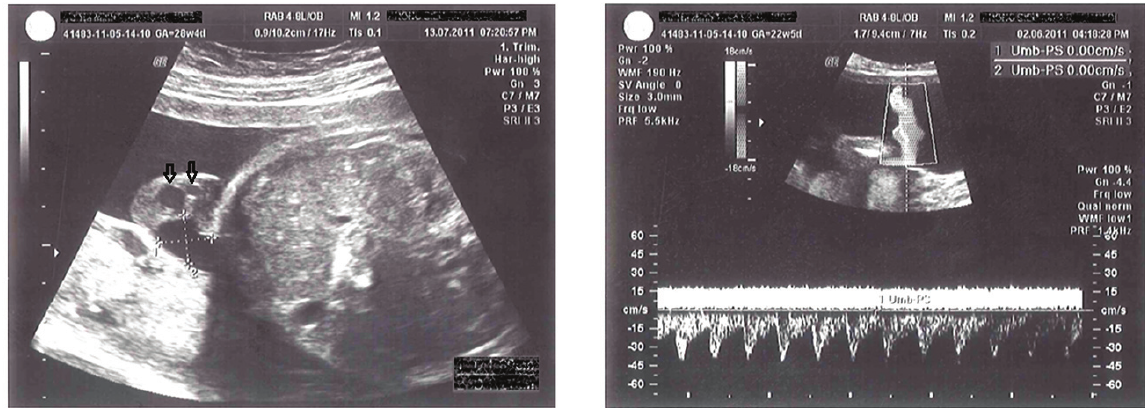
Figure 1. Traditional and Doppler ultrasound assessment showed only one umbilical artery